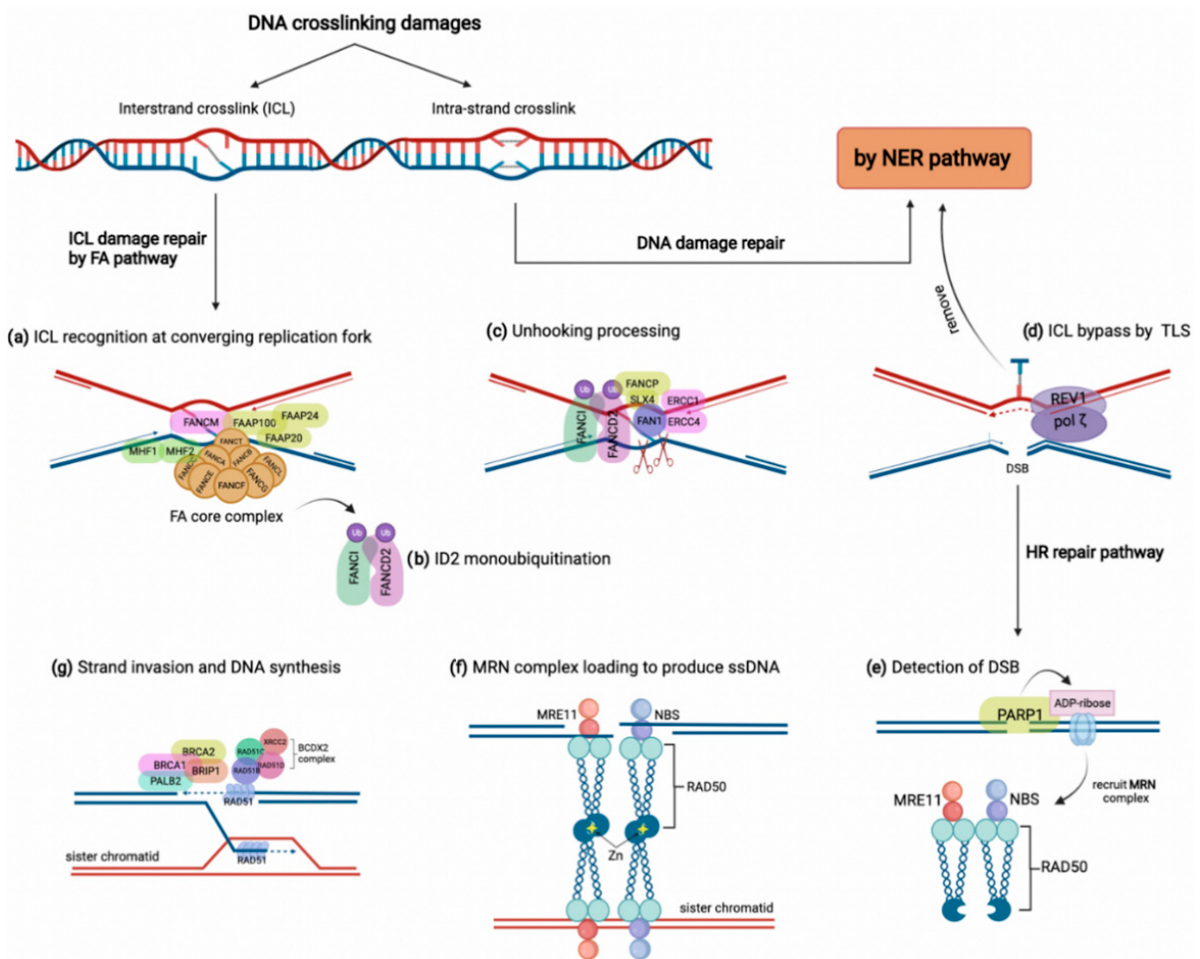
Figure 1. The FA pathway and inter-strand crosslink (ICL) repair. DNA crosslinking damages generally include intra-strand and inter-strand crosslink damages, which are repaired by NER and FA pathways, respectively. ( a ) In the FA pathway, the ICL damage is recognized by FANCM accompanying some other FAAPs at converging replication fork, which results in FA core complex loading along with FAAP100, FAAP20, and FAAP24, as well as MHF1 and MHF2. ( b ) FA core complex activates the ID2 complex by monoubiquitylation of FANCI and FANCD2. ( c ) Monoubiquitylated ID2 complex activates several endonucleases, such as FAN1, to stimulate unhooking processing of the ICL. ( d ) The unhooked ICL is removed by the NER pathway and bypassed by translesion synthesis polymerases REV1/pol ζ . ( e , f ) The HR pathway is recruited to repair the DSB on the other strand. After detection of DSB by PARP1, ADP-ribose molecules recruit the MRN complex to produce single-strand DNA and bind sister chromatid through a tail-to-tail link with another MRN complex. ( g ) Some FA members, such as BRCA1, BRCA2, BRIP1, and PALB2, in addition to the BCDX2 complex, induce the attachment of FANCR/RAD51 to ssDNA, which promotes strand invasion and DNA